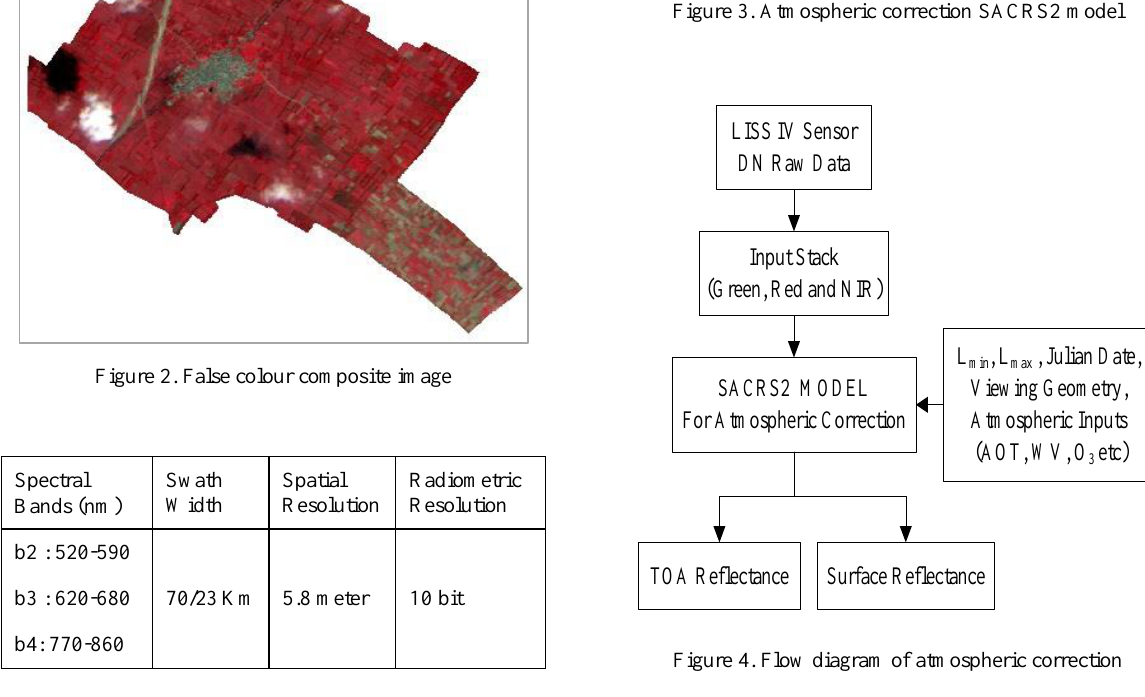
Table 1. LISS-IV sensor data specification